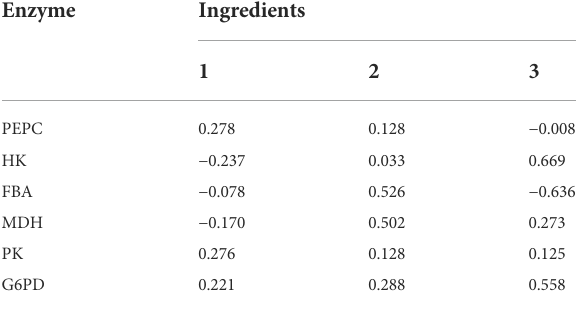
TABLE 5 Matrix of principal component scoring coef fi